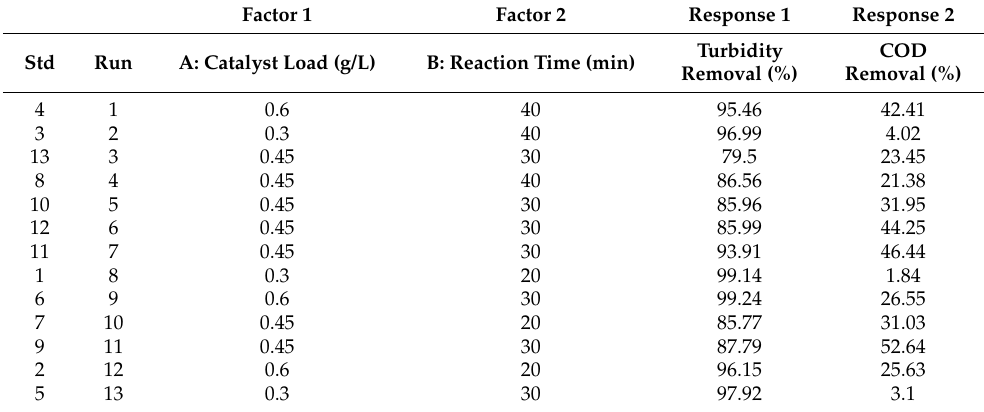
Table 3. Operating parameters generated from RSM and the experimental responses.